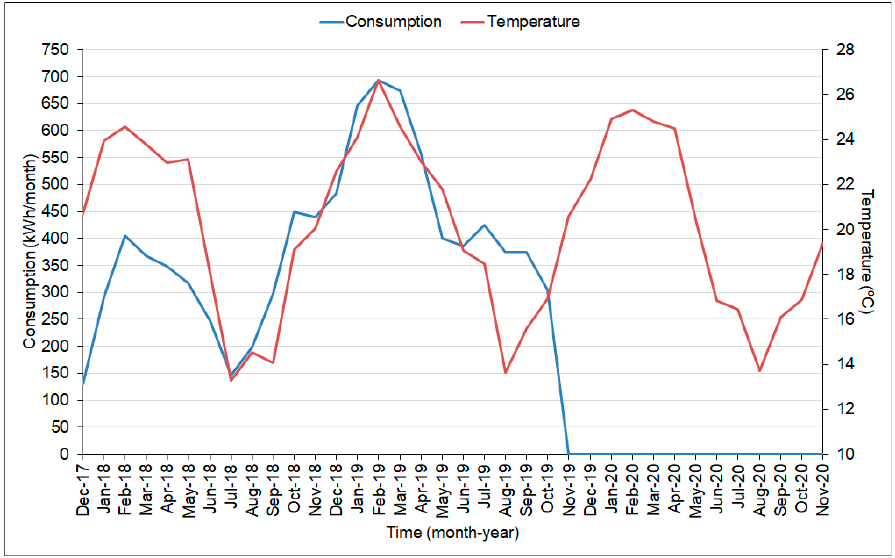
Figure 11. CU-1 Consumption Profile.